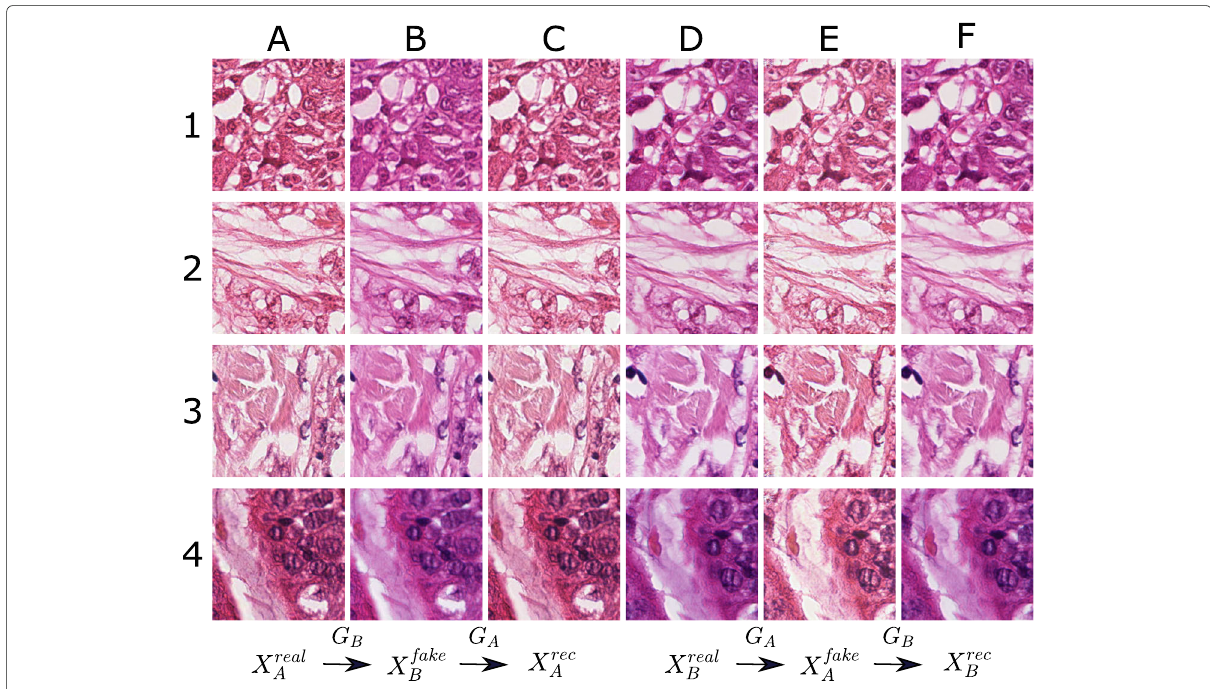
Fig. 3 Results gallery from our experiments on the Mitos-Atypia-14 challenge data set. Columns A-C refer to the image tiles scanned by the Aperio ) being mapped by the generator G B to produce the corresponding image in the domain of the Hamamatsu scanner ( X fake scanner ( X real A reconstruction from mapping the image back to its source domain ( X rec direction for image tiles scanned in domain B , i.e X real